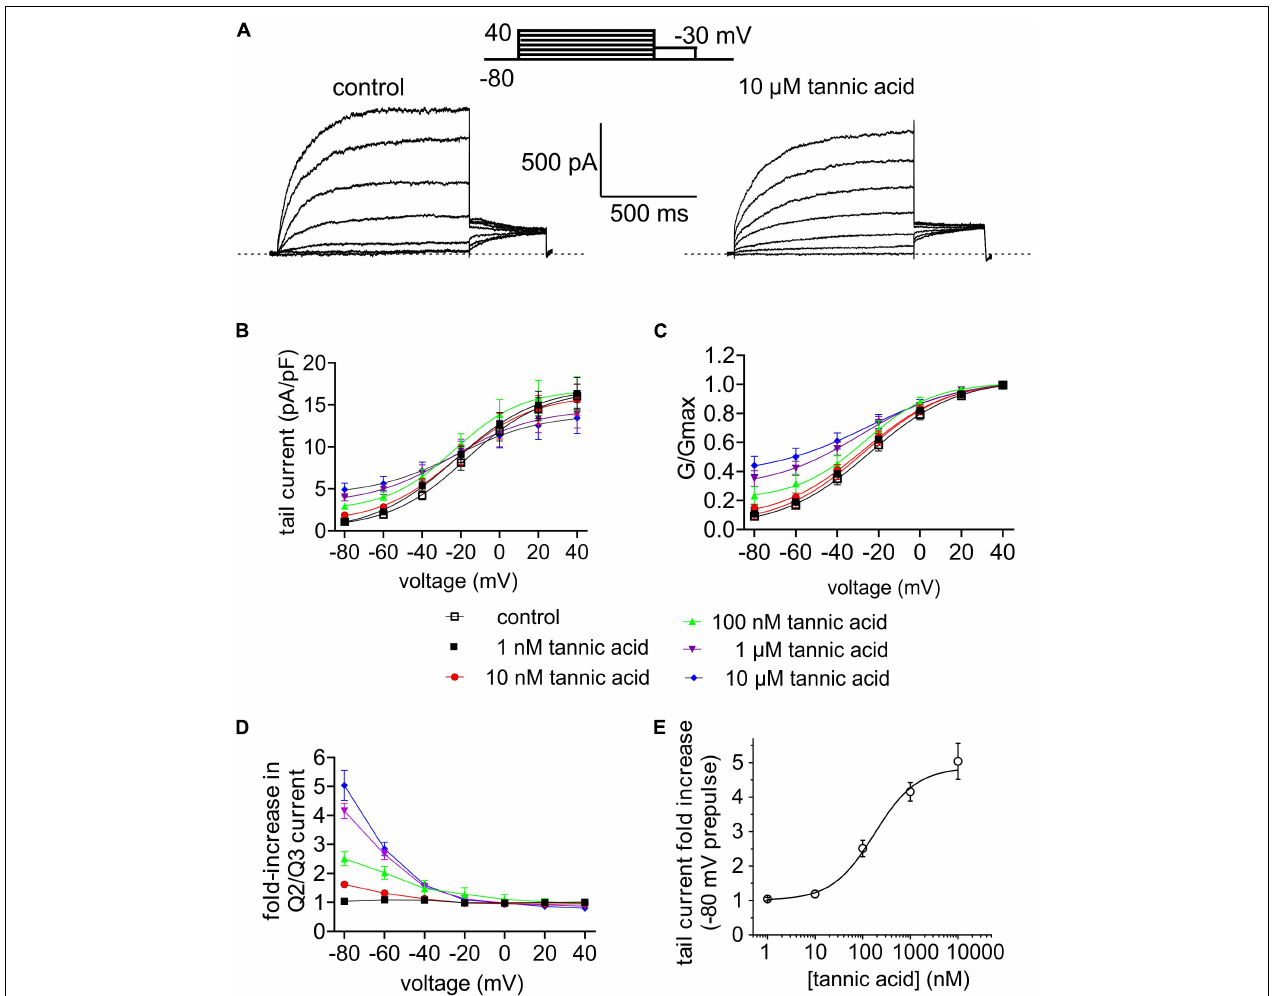
FIGURE 7 | Tannic acid is a potent activator of KCNQ2/3 channels expressed in CHO cells. All error bars indicate SEM. n = number of cells. (A) Exemplar whole-cell patch clamp traces of CHO cell-expressed KCNQ2/3 in the absence (control) and presence of tannic acid (10 µ M). Upper inset: voltage protocol. (B) Mean tail current versus prepulse voltage relationships for traces as in panel (A) at tannic acid concentrations indicated in key below ( n = 10). (C) Mean normalized tail currents (G/Gmax) versus prepulse voltage relationships for traces as in panel (A) at tannic acid concentrations indicated in key below ( n = 10). (D) KCNQ2/3 current fold-change versus voltage at various tannic acid concentrations indicated in key above for cells recorded as in panel (A) ( n = 10). (E) Tannic acid dose response for KCNQ2/3 current increase at –80 mV for cells as in panel (D) ( n =